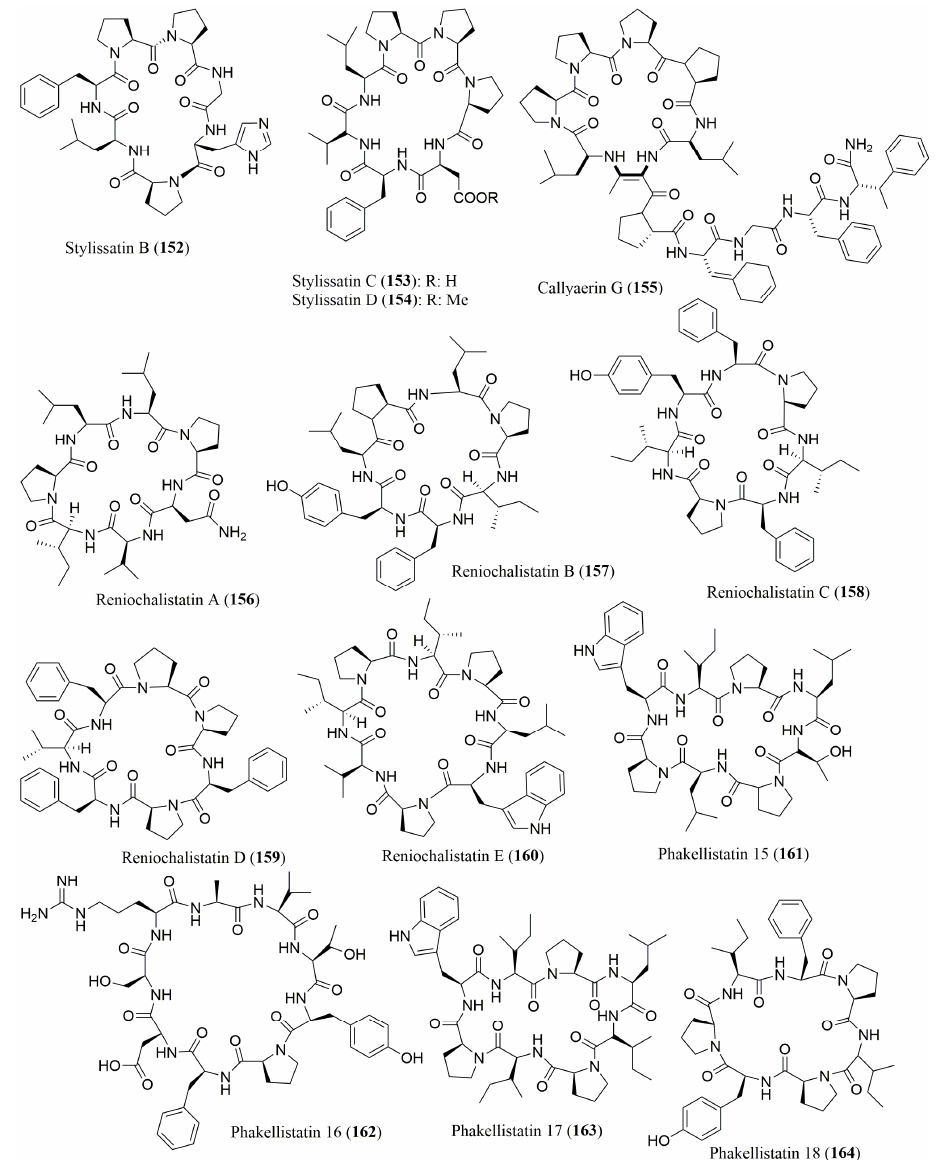
Figure 11. Structure of cyclic peptides 152 – 164 , isolated from marine sponges.